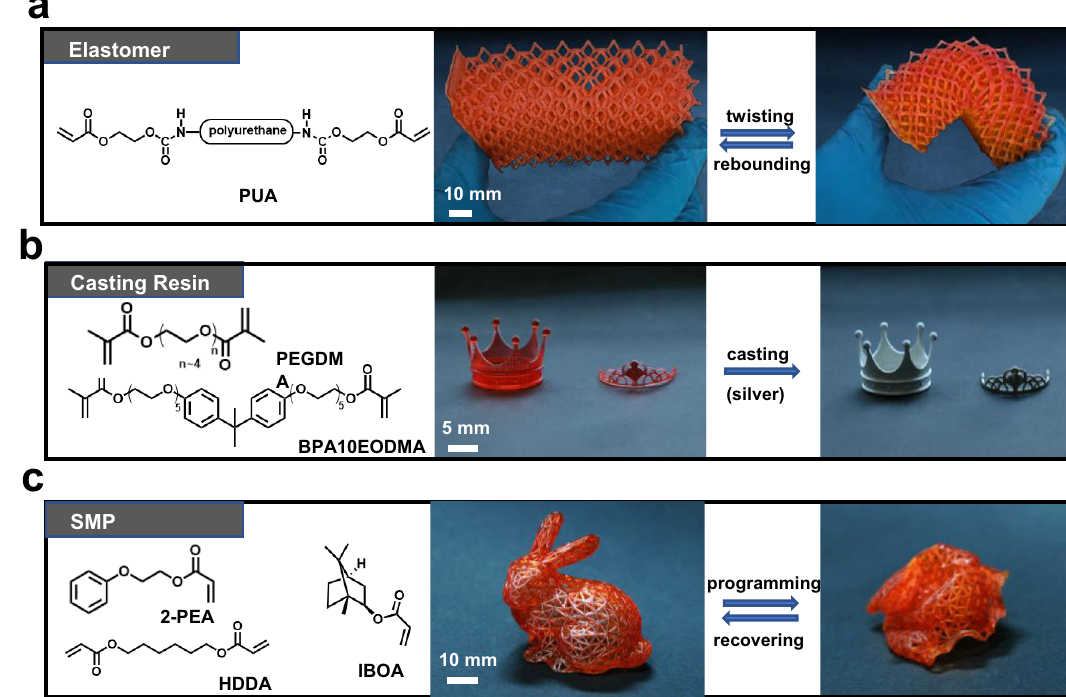
Fig. 5 Diversity of the resins that are compatible with the hydrogel interface. a Elastomers. b Casting resins. c Shape memory